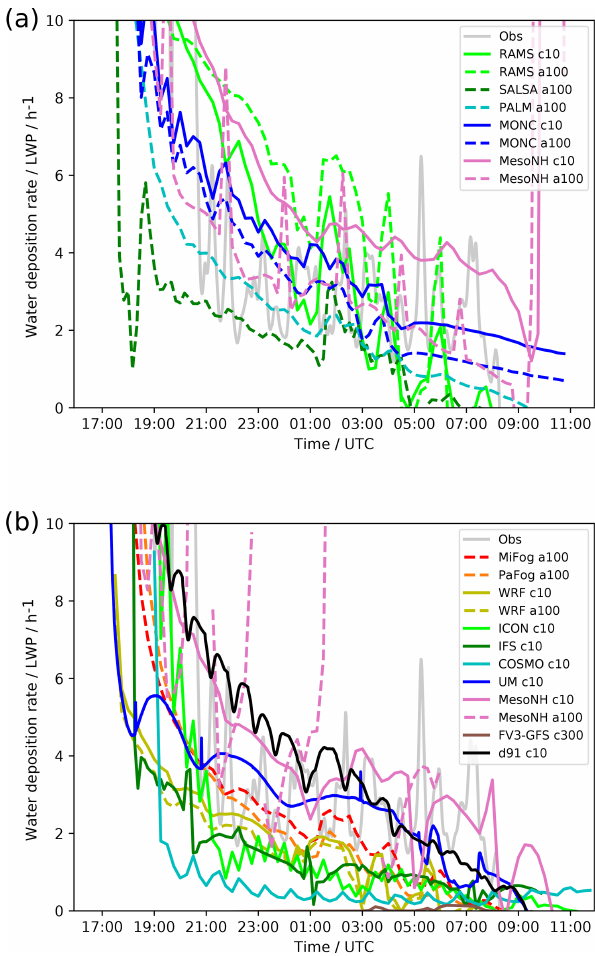
Figure 2. Water deposition rate divided by liquid water path ob- served and modelled by (a) low aerosol/CDNC LES and (b) low aerosol/CDNC SCMs.